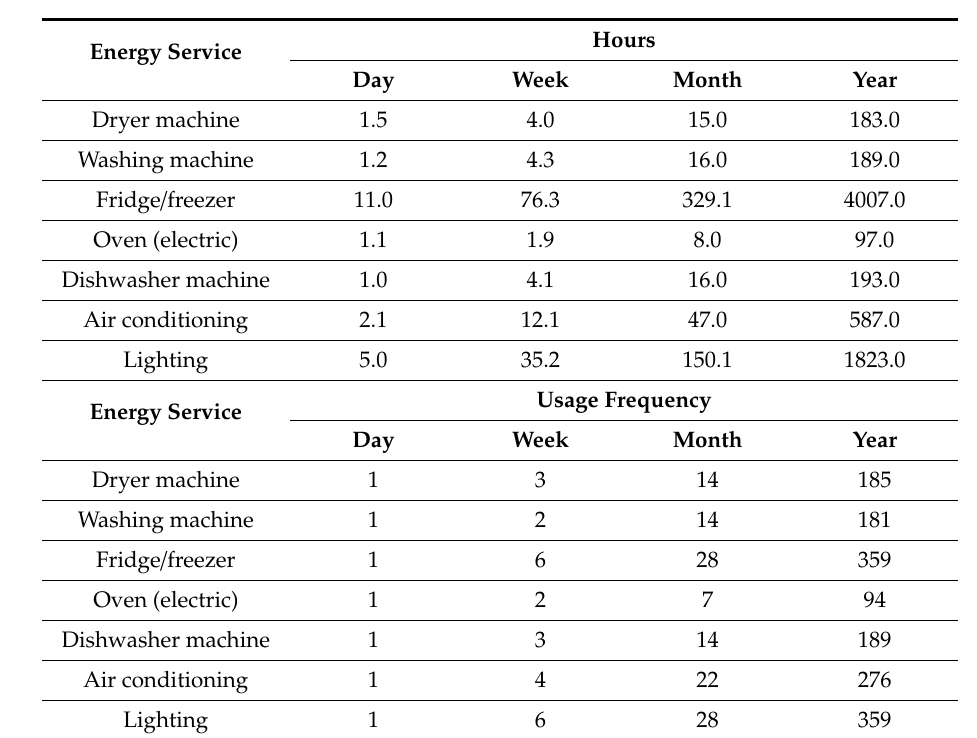
Table 2. Consumer usage profile